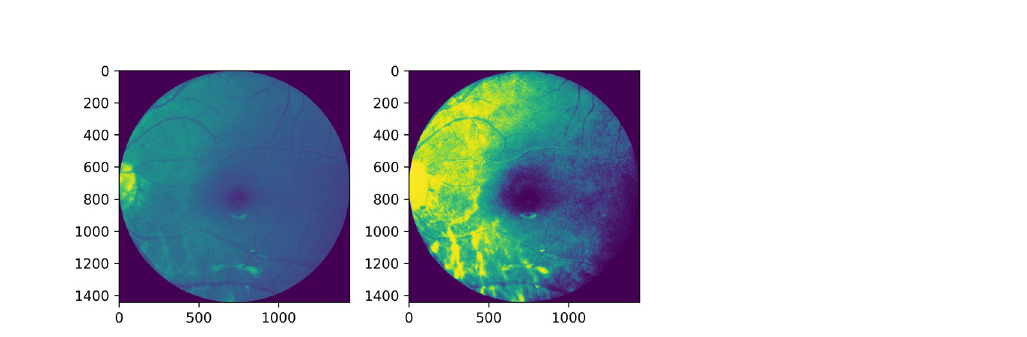
Figure 5. Red channel extracted image and its histogram